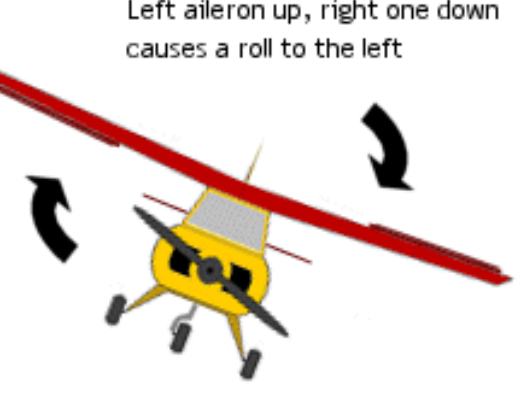
Figure 2. Roll and the way it is